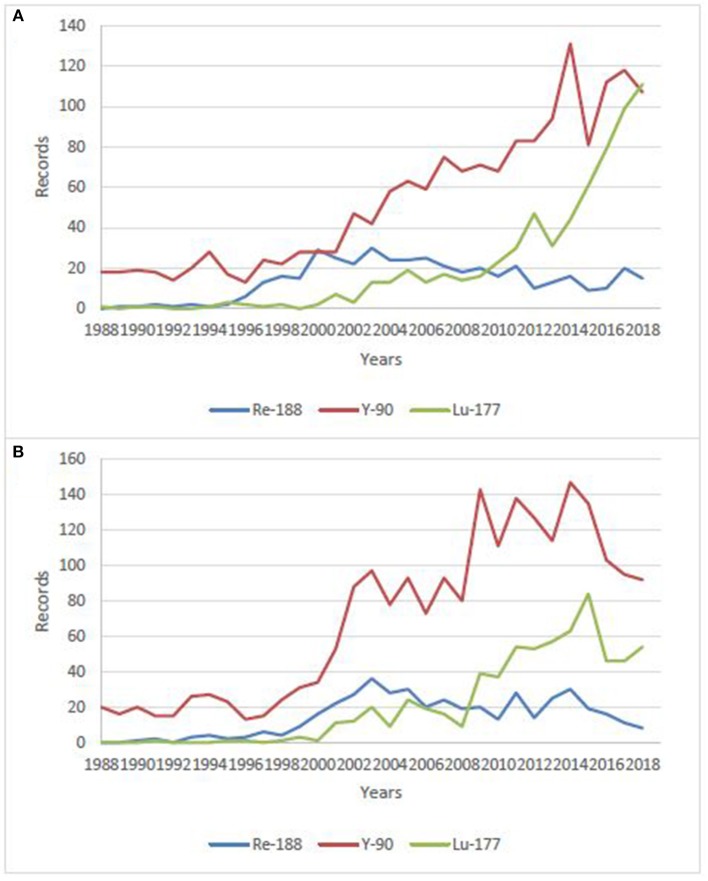
Number of publications/year on clinical use of 188Re, 177Lu and, 90Y over the last 30 years. (A) data from Sci-Finder, ©2019 American Chemical Society, (B) data from Web of Science, ©2019 Clarivate Analytics.